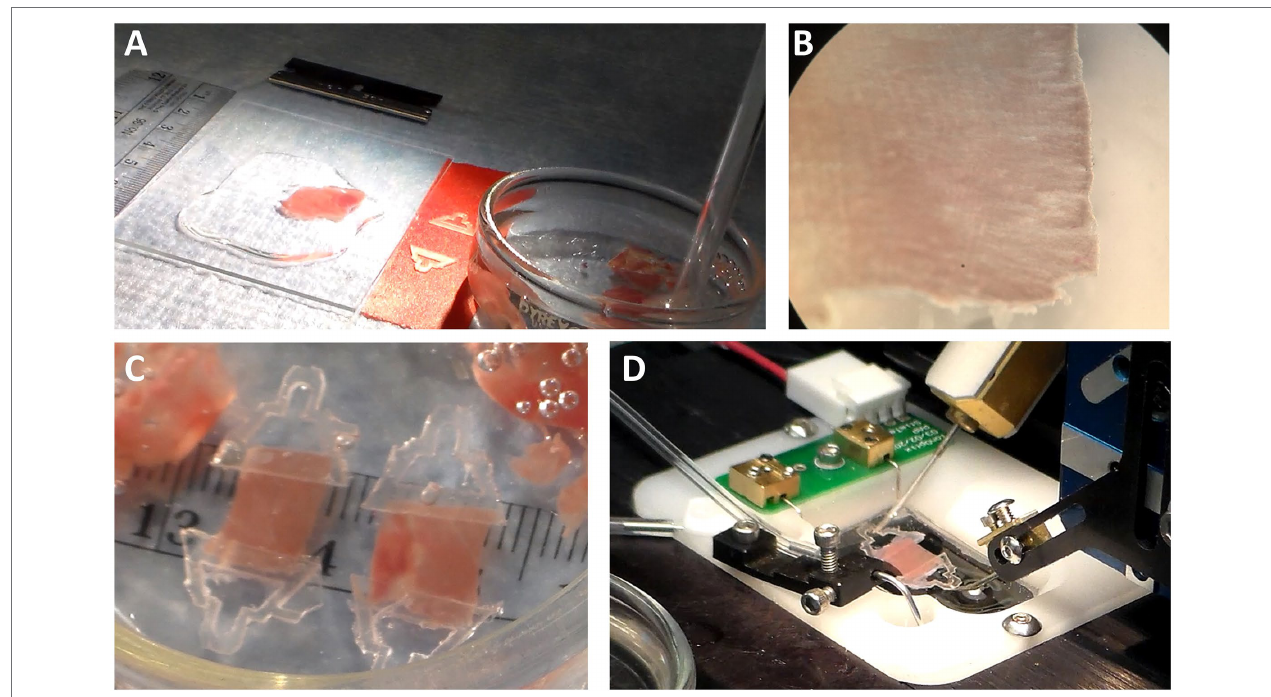
FIGURE 5 | Clipping a Cardiac Slice. (A) The area required for clipping must be well lit surrounded by the necessary materials. (B) Fiber orientation must be detected using a dissection microscope. In this example, the fibers are running left to right. The lines running up and down are either creases from the cutting action of the blade and can be reduced with slower cutting speed. (C) Examples of clipped slices show the dimensions are roughly 10 mm long × 5–8 mm wide x 0.3 mm thick. (D) The clips permit the slice to be mounted into the recording